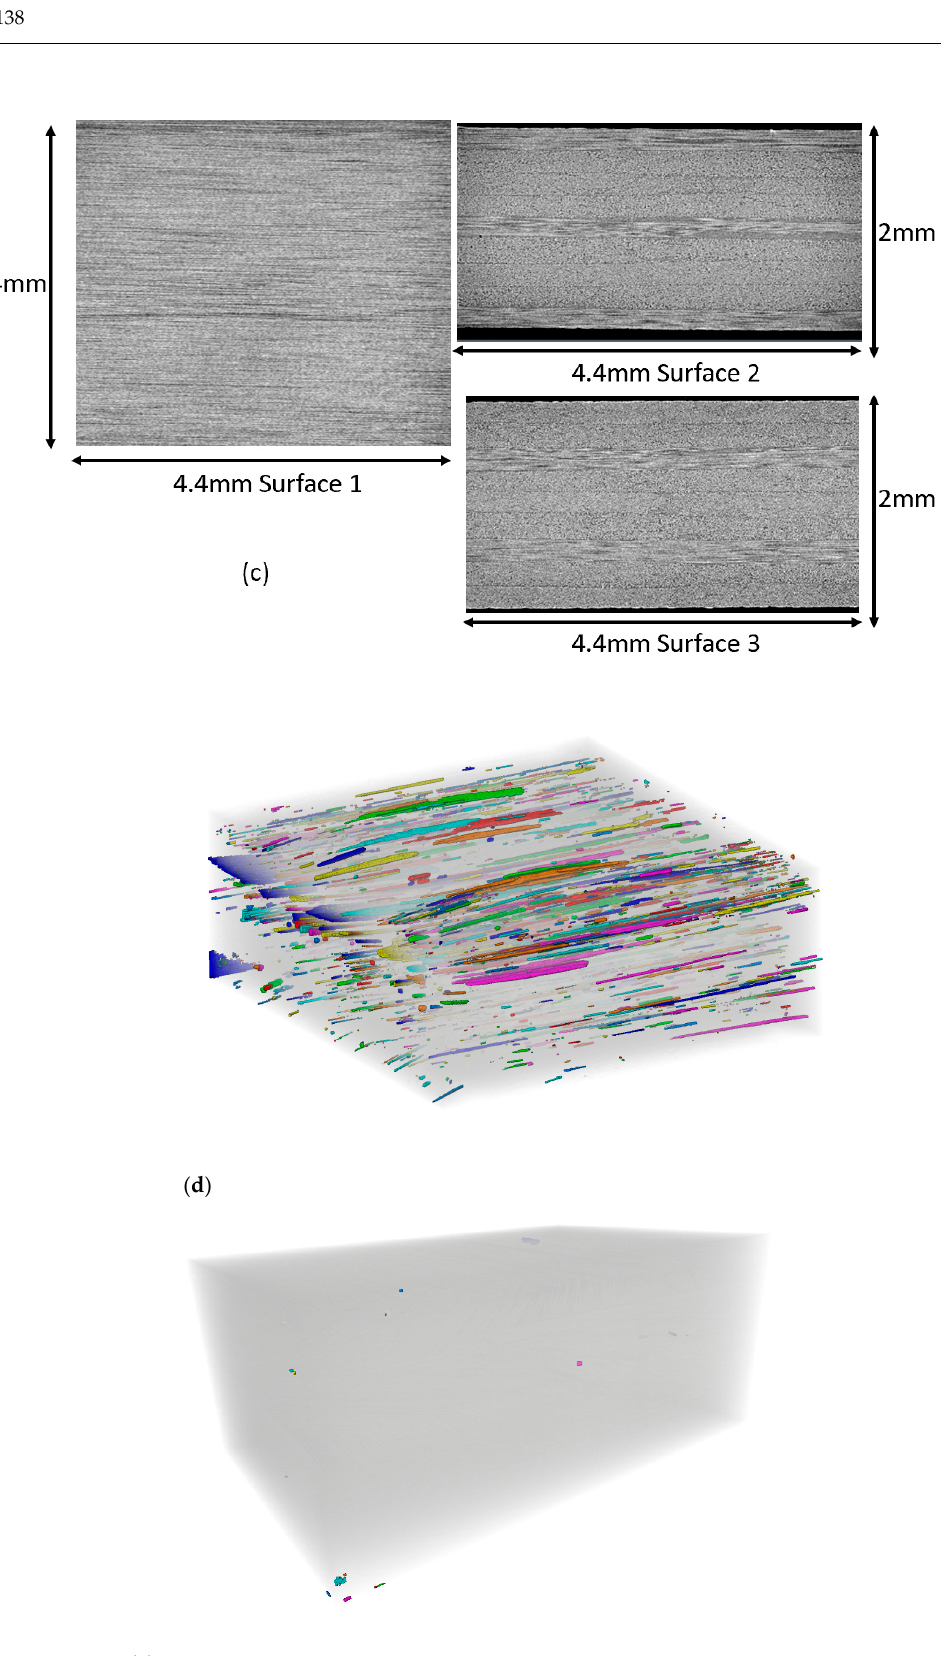
Figure 8. CT analysis of the CFRP samples: ( a ) Sketch of the cut planes for two-dimensional microstructure characterization. Two-dimensional microstructure of unidirectional ( b ) and multi-directional ( c ) CFRP. Three-dimensional microstructure of unidirectional ( d ) and multidirectional ( e ) CFRP with pores shown in color. Figure 8a sketches the cut planes for two ‐ dimensional microstructure characteriza ‐ tion. Figure 8b,c show cross sections along the three orthogonal directions for the uni ‐ and multidirectional CFRP, respectively. The section orientations are the same for both sam ‐ ples, and black areas represent pores. In Figure 8b, it can be seen that many pores are present in the middle area. This observation can be explained by an inhomogeneous dis ‐ tribution of the temperature and curing degree in the middle of the sample, as well as by the fact that the trapped pores in the middle of the sample have more difficulties in mi ‐ grating to the edge during curing. In contrast to the unidirectional CFRP, only a few pores are found in the multidirectional sample. As reported in previous work [7], more pores could be induced in multidirectional CFRP than in unidirectional CFRP owing to the fol ‐ lowing reasons: (1) because of the complex stacking sequence, the air entrapment in mul ‐ tidirectional CFRP is more pronounced, and (2) a nonuniform distribution of the pressure and temperature leads to a nonuniform curing degree in multidirectional CFRP. How ‐ ever, the reverse case is observed in the present work, which can be explained by the em ‐ ployed process parameters not being optimized for both types of laminates. However, the present work focuses on the residual stress analysis, while process parameter optimiza ‐ tion was out of scope. A three ‐ dimensional image of the unidirectional CFRP sample is shown in Figure 8d, revealing interlaminar and intralaminar pores. Most of the pores are elongated in the ad ‐ jacent fiber direction and are quite long (needle ‐ like voids). In line with the two ‐ dimen ‐ sional images in Figure 8c, the three ‐ dimensional image of the multidirectional CFRP (Fig ‐ ure 8d) shows hardly any pores at all, keeping in mind that pores of dimensions similar to the voxel size are not displayed. Based on the assessment of CT data, the porosity of the uni ‐ and multidirectional CFRP is 1% and 0.05%, respectively. 3.2. Calibration Coefficients: Relation between Residual Stress and Surface Strain Details about the calculation of the calibration coefficients have been introduced in Section 2.1. In the following, the influence of the stacking sequence and the presence of pores on the calculated calibration coefficients is presented.